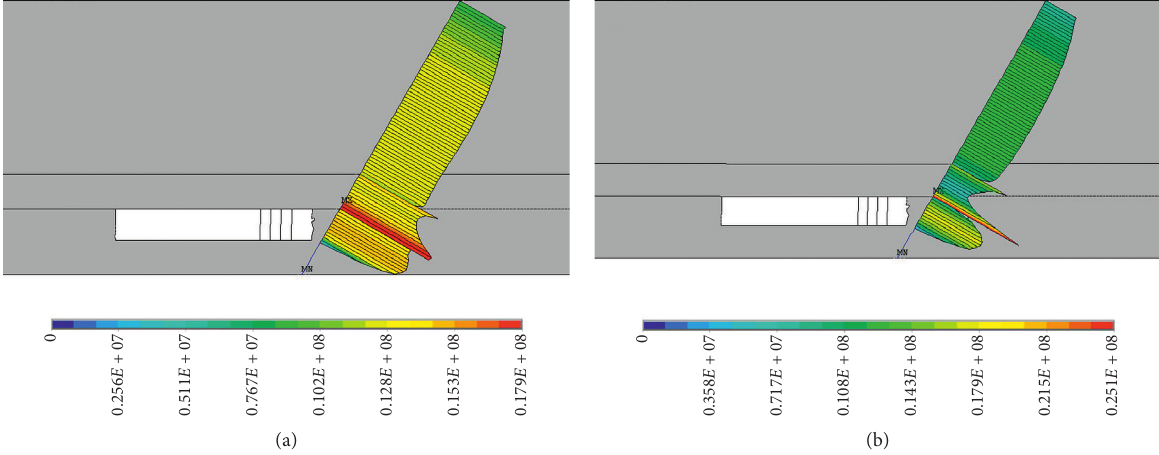
Figure 24: The nephogram of contact pressure when work face is near the fault (reverse direction fault). (a) Without searching tunnel. (b) With searching